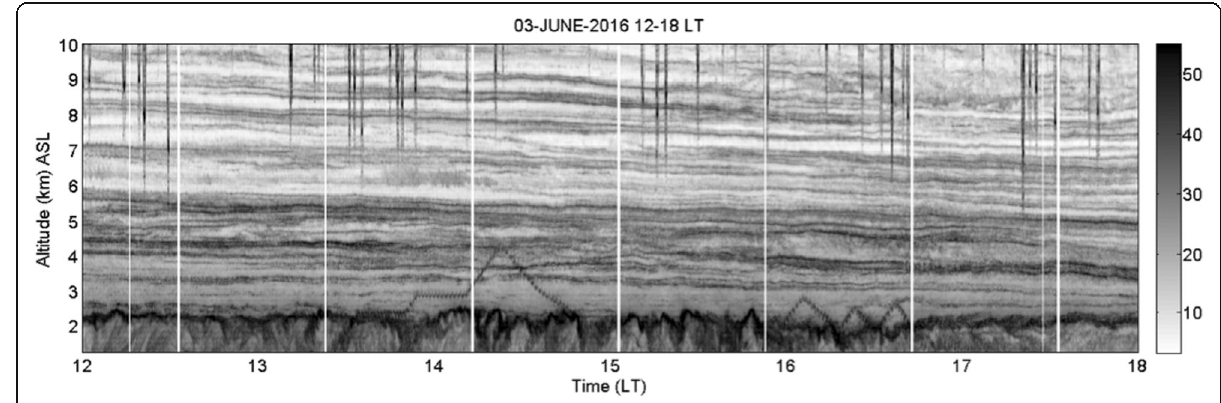
Fig. 5 As in Fig. 1 but from 12:00 to 18:00 LT on June 3, 2016 during the ShUREX 2016 campaign. In the lower part, the top of the convective boundary layer, with associated plume activity, can be seen at a height of around 2 km. Sheet and layer structures with apparently no turbulence activity can also be seen above the CBL. Dark thin lines inside and above the CBL denote UAV